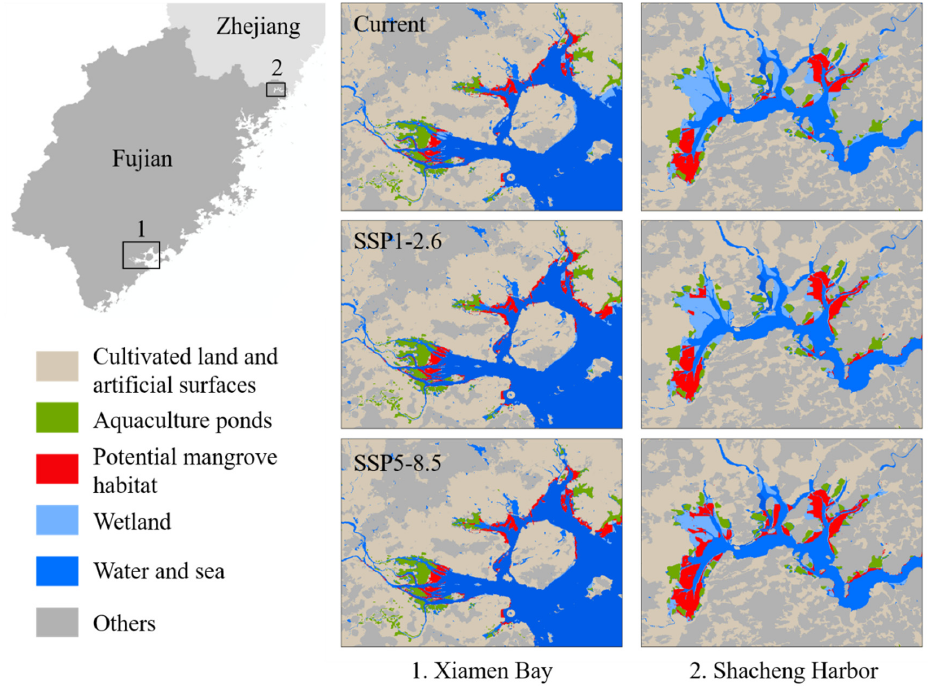
Figure 8. Land-use influence on suitable habitats of mangrove concentrated distribution areas under current and future scenarios.